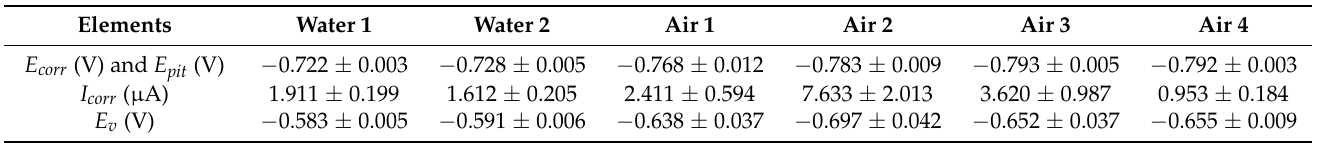
Table 4. Corrosion potential and corrosion current along with their standard deviations at different locations of the quenched AA7075-T6 in 3.5%